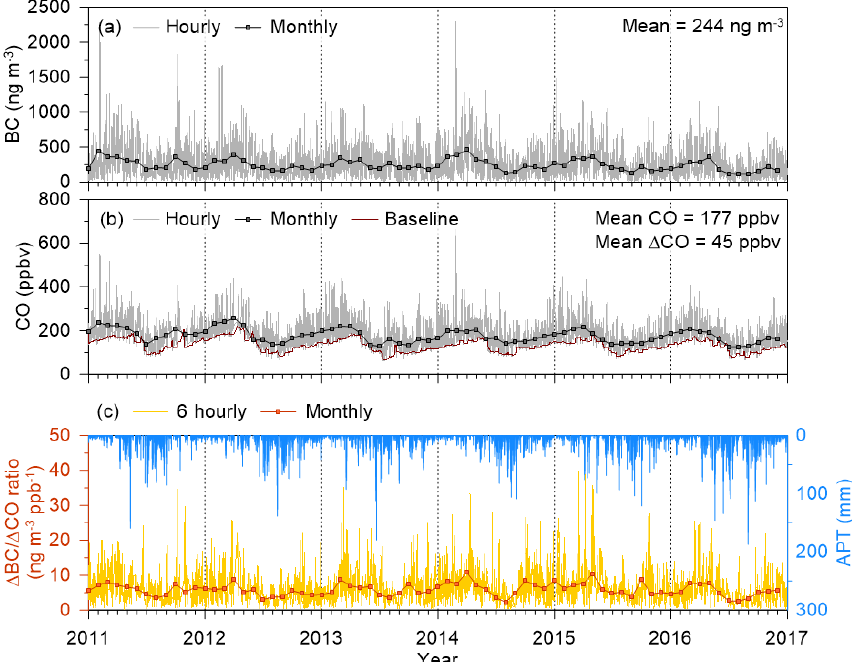
Figure 2. Time series of (a) BC concentration, (b) CO and (cid:49) CO concentrations, and (c) (cid:49) BC /(cid:49) CO ratio and accumulated precipitation along with trajectory (APT) during the measurement periods (from 2011 to 2017) in Noto, Japan. The square symbols with solid lines in (a) and (b) indicate hourly and monthly concentrations.